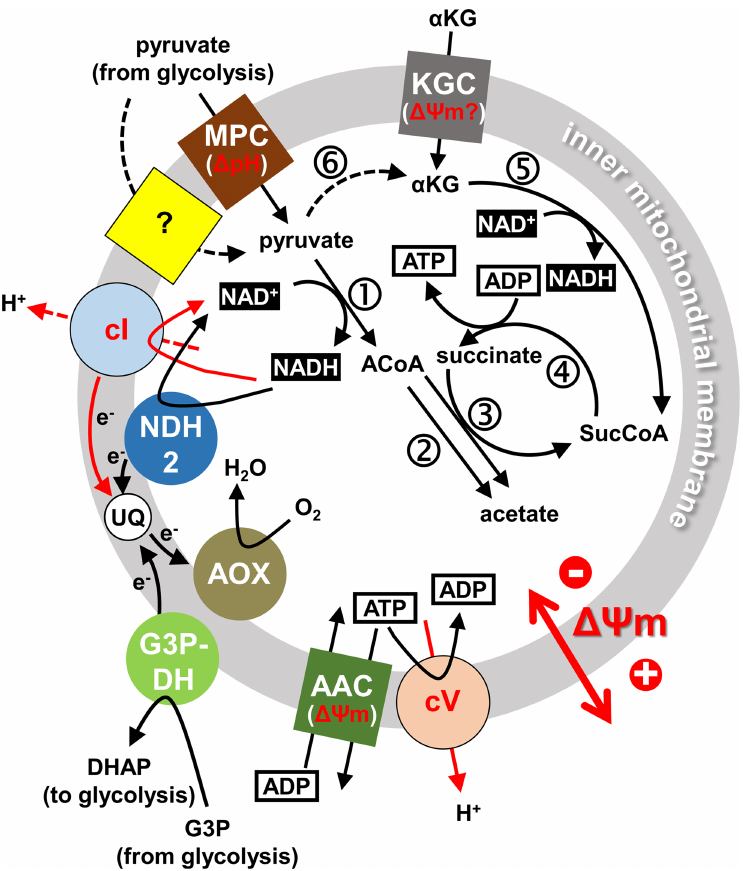
Fig 8. Proposed mitochondrial energy metabolism of stumpy form T . brucei cells in the bloodstream. Schematic representation of key functions we propose to be involved in energy metabolism of stumpy form T . brucei , based on data presented in this work and in earlier studies, as cited in the text. Note that energy metabolism in other compartments such as adipose tissue or skin will very likely be different. Transporters in the inner mitochondrial membrane are shown as coloured squares (MPC, mitochondrial pyruvate carrier; KGC, α -KG carrier; AAC, ATP/ ADP carrier). A two-subunit mitochondrial pyruvate carrier, MPC1/2, presumably driven by proton symport, has been identified in T . brucei , but functional studies concluded that at least one additional mitochondrial pyruvate transporter must be present [74], indicated here by a yellow square with a question mark. Enzymes or enzyme complexes associated with the inner membrane are shown as coloured circles (cI, NADH:ubiquinone oxidoreductase; cV, F 1 F O -ATPase, or respiratory complex V; G3P-DH, glycerol-3-phosphate dehydrogenase; AOX, alternative oxidase; NDH2, type 2 NADH dehydrogenase). Functions that directly depend on kDNA-encoded proteins are indicated by red letters and arrows. Key metabolic reactions in the mitochondrial matrix are indicated by numbers in circles: 1, pyruvate dehydrogenase; 2, acetyl-CoA thioesterase; 3, ASCT; 4, SCoAS; 5, α -KG dehydrogenase complex; 6, L-alanine aminotransferase (co-substrate glutamate and co-product alanine omitted for simplicity). Other abbreviations: UQ, ubiquinone; G3P, glycerol-3-phosphate; DHAP, dihydroxyacetone phosphate; ACoA, acetyl-CoA; SucCoA, succinyl-